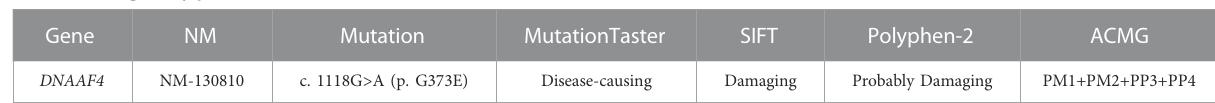
TABLE 2 Pathogenicity prediction of DNAAF4